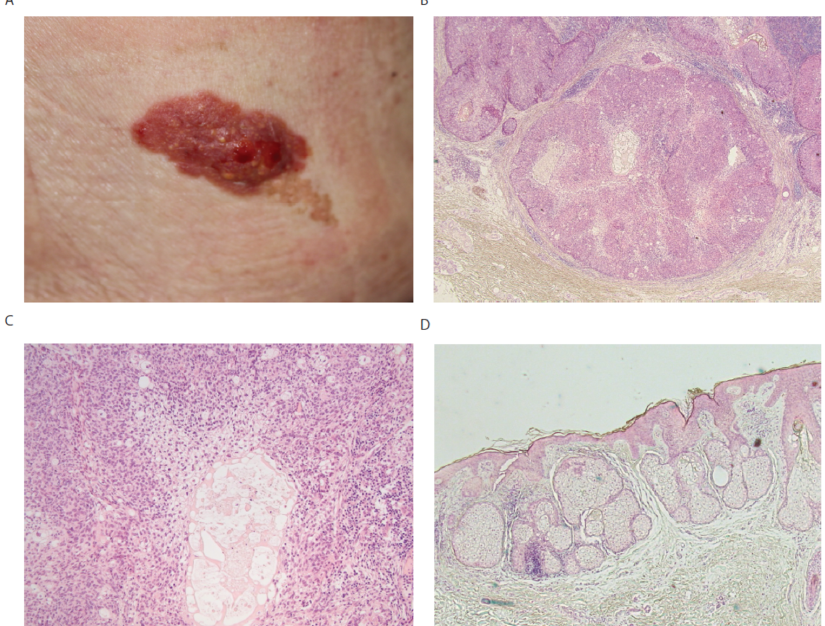
Figure 2. ( A ) A red tumor covered with granular papules adjacent to a brown plaque. ( B ) Atypical basaloid cells form irregular lobular nodules with infiltrative growth pattern in dermis. ( C ) Sebaceus differentiation with a foamy cytoplasm in the center of nodules. High magnification of ( B ). ( D ) Increased multiocular pilosebaceus glands in the dermis. Nevus sebaceus is a congenital hamartoma, which is clinically a yellowish plaque. Nevus sebaceus frequently occurs on the scalp and face. However, some cases with nevus sebaceus on the chest have been reported [1]. In total, 417 cases (92.6%) out of 450 cases were on the scalp and face, while 4 cases (0.8%) were on the trunk [2]. In one of our cases, nevus sebaceus was detected on the back, which is quite rare. We found only one case with basal cell carcinoma arising in the nevus sebaceus on the upper right back [3]. It has been reported that trichoblastoma is the most common secondary neoplasm that arises within nevus sebaceus [4]. Out of 243 cases with nevus sebaceus, only one case (0.4%) developed sebaceus carcinoma [4]. Another report demonstrated that 38 (8.5%) of 450 cases with nevus sebaceus developed secondary neoplasms, including syringocystad- enoma papilliferum (2.7%), the most common tumor [2]. Basal cell carcinoma developed in 4 cases (0.9%) and was the most frequent malignant tumors in nevus sebaceus [2]. Nod- ular type of basal cell carcinoma arising from nevus sebaceus has been recently reported [5]. Sebaceus carcinoma occurred in only one case (0.2%) out of 450 cases of nevus se- baceus [2]. According to several articles, multiple tumors rarely happen in the nevus sebaceus simultaneously. Sebaceus carcinoma, trichoblastoma, and poroma were detected in one case with nevus sebaceus [6]. Coexistence of adenosquamous carcinoma, trichoblastoma, trichilemmoma, sebaceus adenoma, tumor of follicular infundibulum, and syringocystad- enoma papilliferum was also reported [7]. The mechanism of multiple neoplasms hap- pening in nevus sebaceus is still unclear, although diversity and different differentiation status of cells composing nevus sebaceus may be partially responsible for it. In conclusion, we presented two cases of malignant tumors arising from nevus se- baceus. Nevus sebaceus should be removed in order to avoid malignant transformation. Skin biopsy is essential to avoid overlooking the disease.